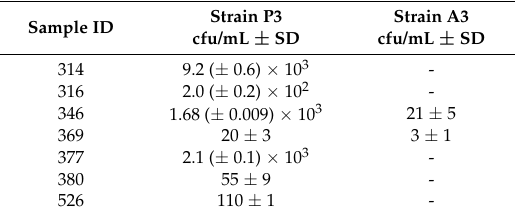
Table 4. Bacteria quantification in groundwater samples. SD, standard deviation ( n = 2).